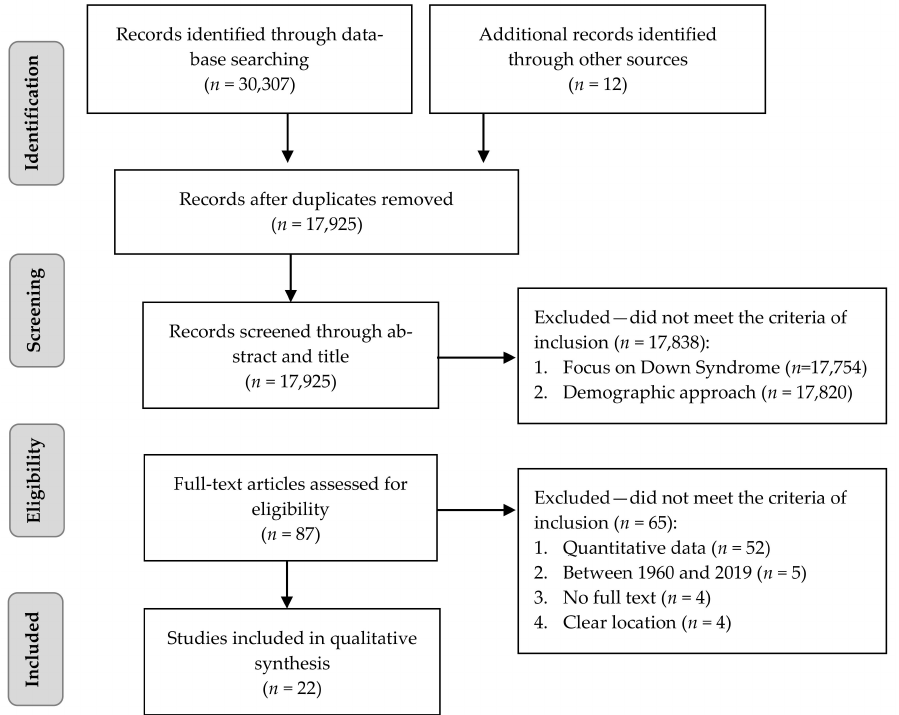
Figure 1. Preferred Reporting Items for Systematic Reviews and Meta-Analyses (PRISMA) Statement flowchart of the study identification, screening, and selection